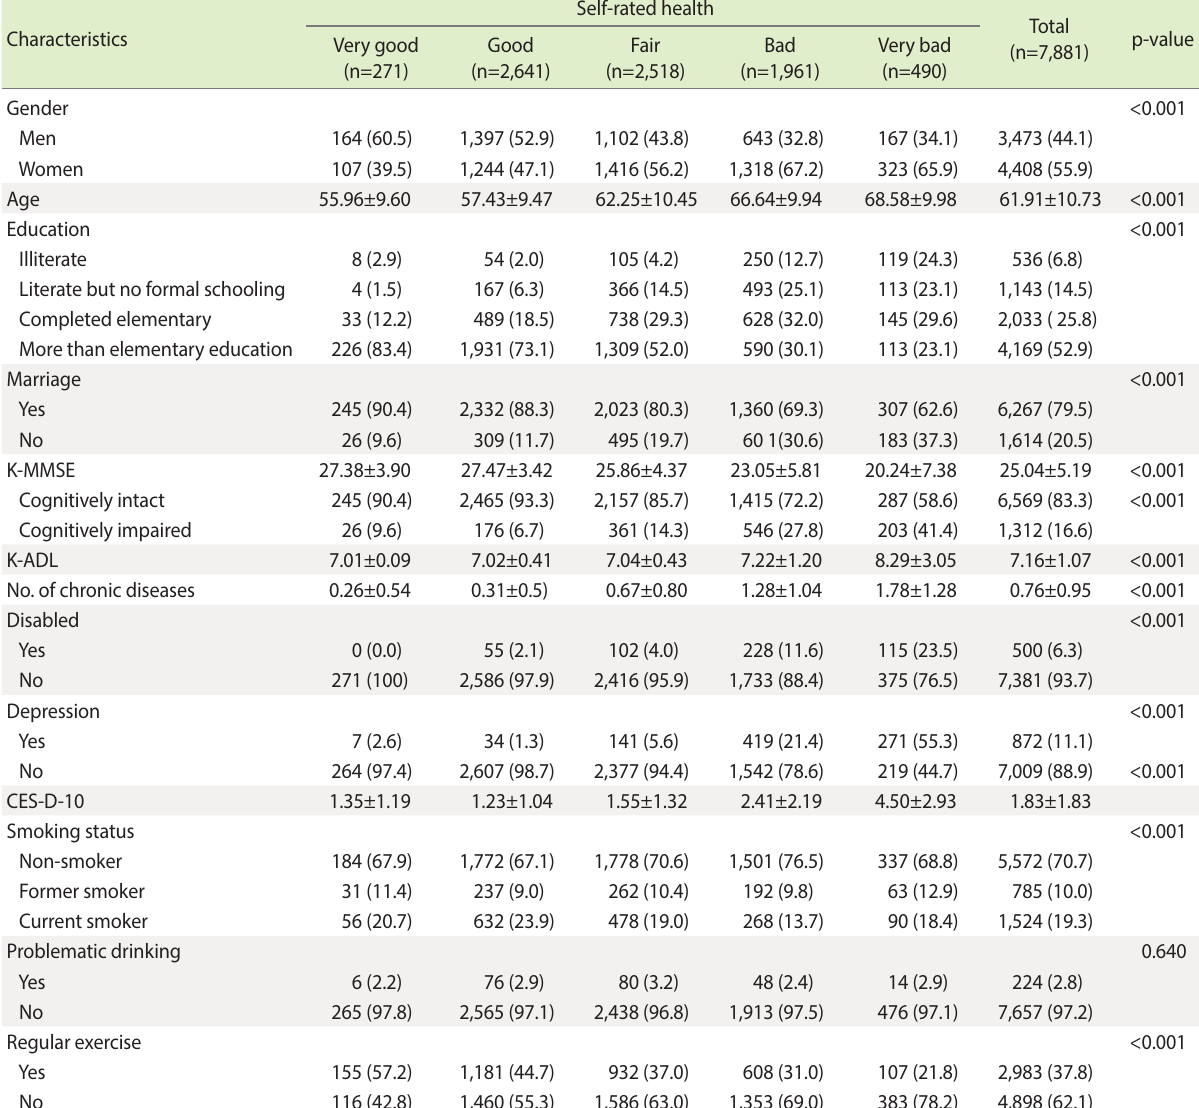
Table 1. Distribution of sample characteristics at baseline,